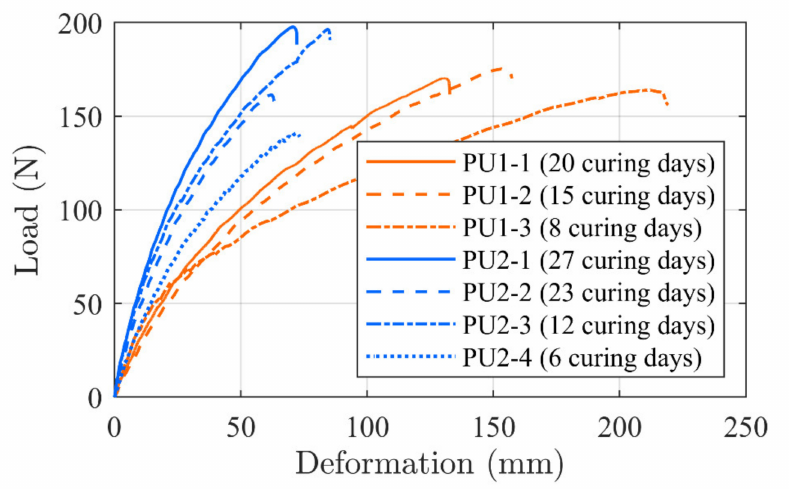
Figure 7. PU dog bone specimen, time related, load–deformation